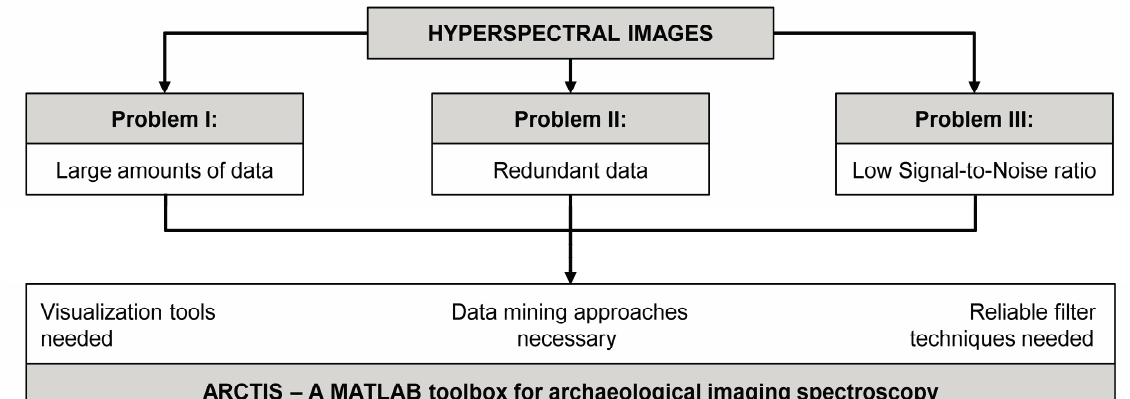
Figure 2. The main challenges that an image analyst is facing when analyzing imaging spectroscopy data for archaeological prospection. The software ARCTIS efficiently addresses these